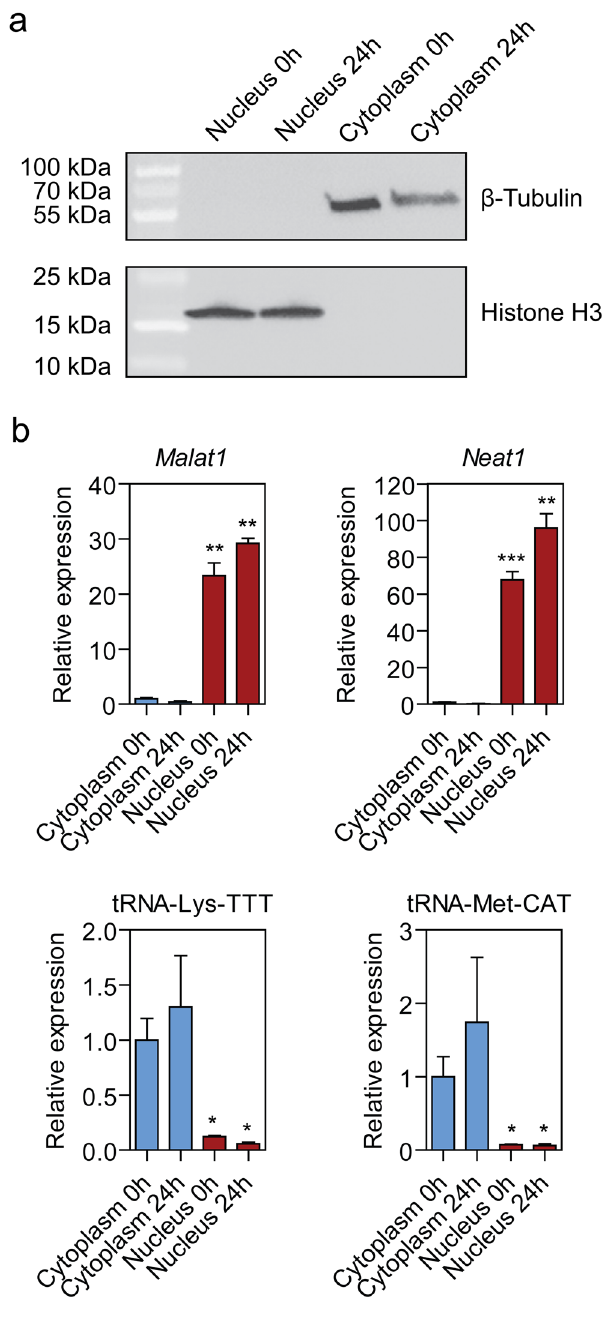
Figure 1. Isolation of nuclear and cytoplasmic fractions. ( a ) Western blot analysis of cytoplasmic ( β -tubulin) and nuclear (histone H3) marker protein expression. ( b ) RT-qPCR analysis of nuclear-enriched lncRNAs ( Malat1 and Neat1 ) or cytoplasm-enriched tRNAs (tRNA-Lys-TTT and tRNA-Met-CAT). Values are mean ± SEM, n = 3–4, * P < 0.05, ** P < 0.01, *** P < 0.001 ( t -test with Welch correction for unequal variance, comparisons are to the matched group-matched Cytoplasmic